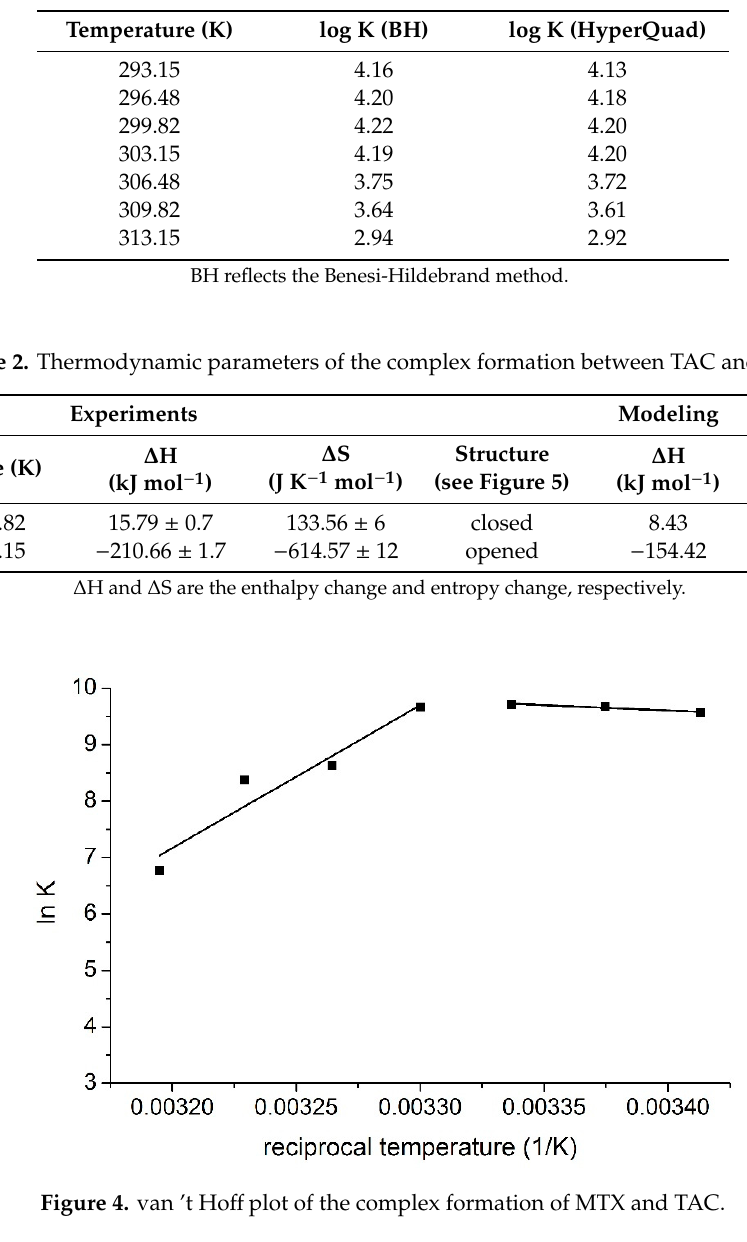
Table 1. Stability constants determined at di ff erent temperatures